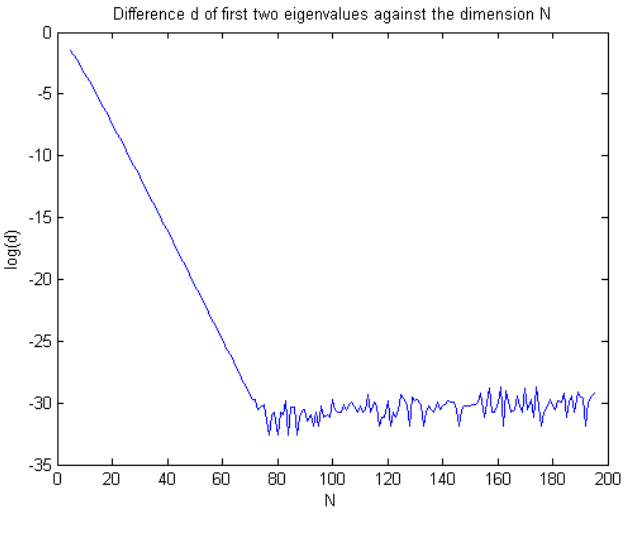
( 0 ) − ε ( 1 ) | between the first two eigenvalues ε ( 0 ) N N , for different values of N on a log scale. From about N + 1